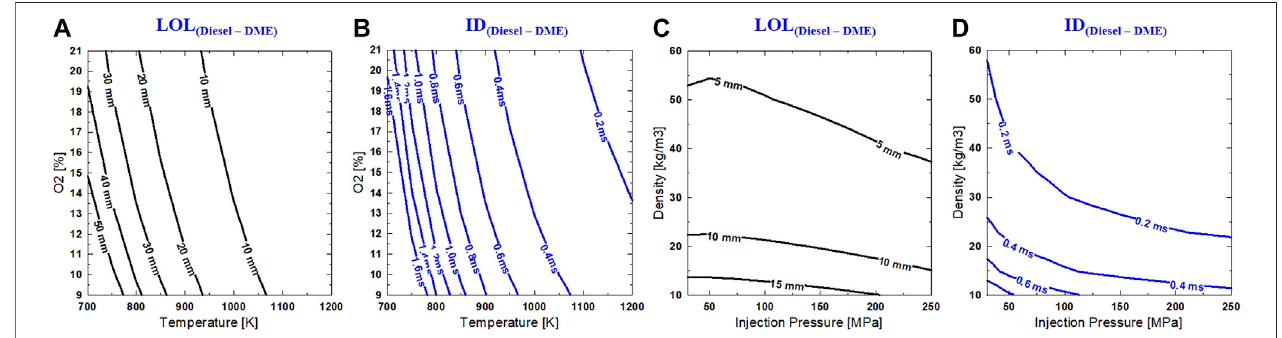
FIGURE 12 | (A,B) Difference in LOL and ID between Diesel and DME in T amb – O 2 (same P inj (cid:1) 750 bar and ρ amb (cid:1) 14.8 kg/m 3 ) and P inj – ρ amb (same T amb (cid:1) 900 K and O 2 (cid:1) 18%) mappings (C,D) .